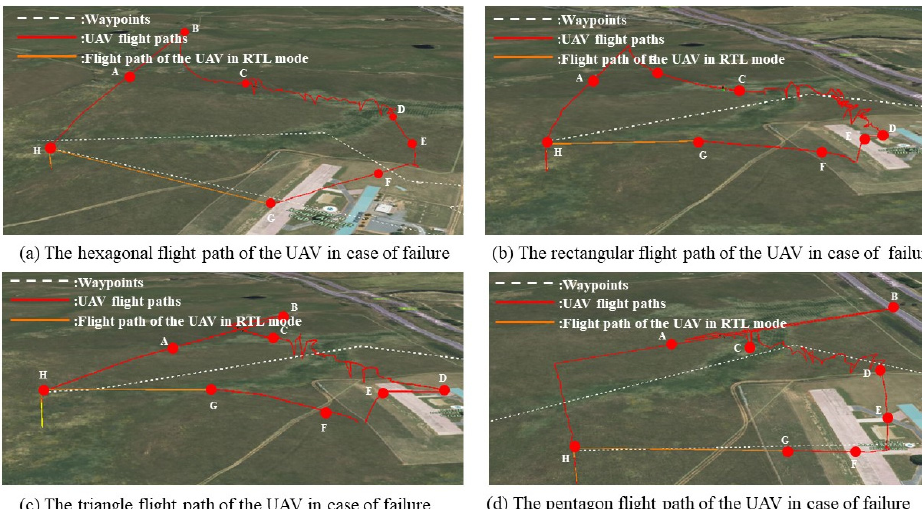
Figure 6. the trajectory of the UAV under QGroundControl during fault